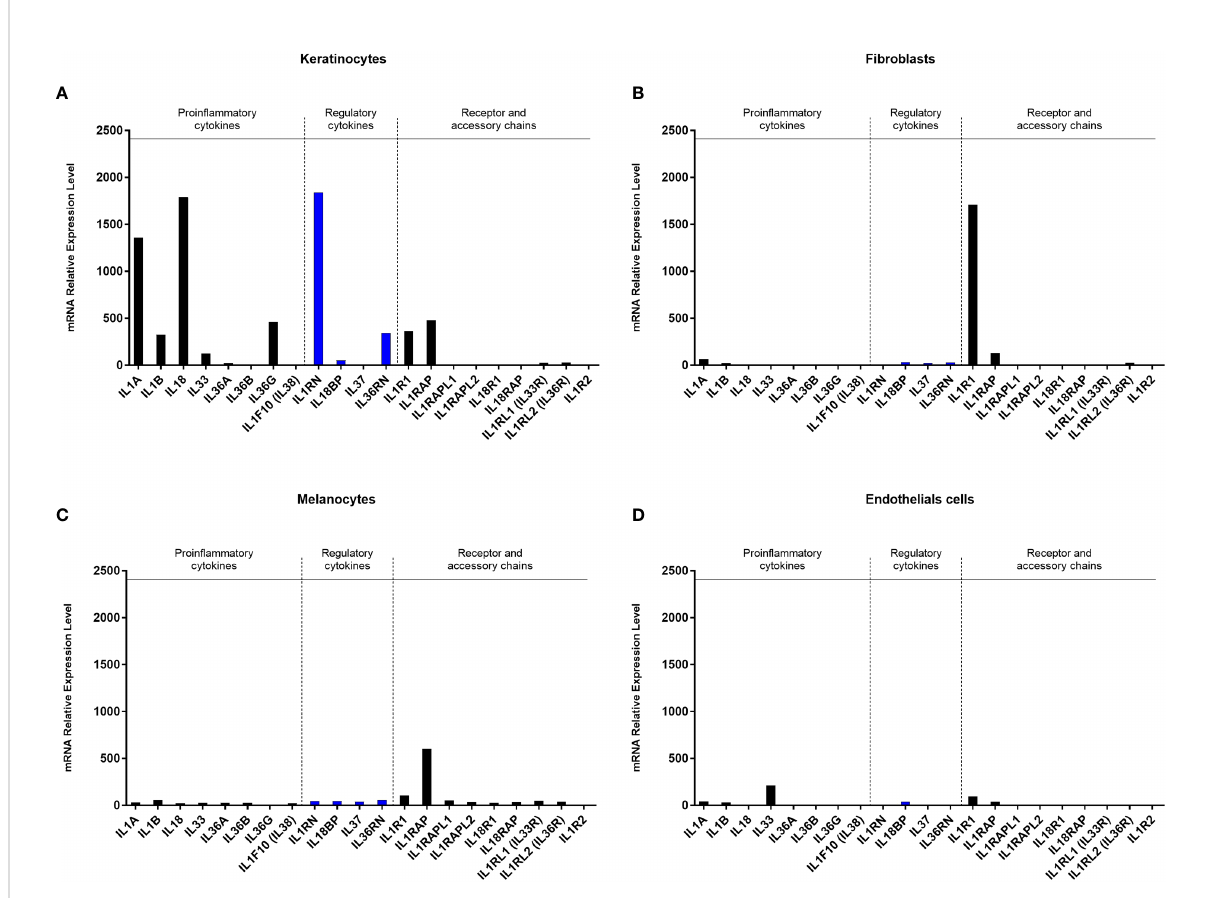
FIGURE 1 Gene expression pro fi les of proin fl ammatory cytokines, regulatory cytokines and receptors of the IL-1 family by different skin cell populations. The expression of the IL-1 family members and their receptors was analyzed at the transcriptional level by Affymetrix analysis (hU219 array) after mRNA extraction of primary cultures of epidermal keratinocytes (A) , dermal fi broblasts (B) melanocytes (C) and dermal microvascular endothelial cells (D) , all isolated from human skin and cultivated in healthy conditions. Averaged data obtained from 2 independent cultures for each cell type are presented in relative expression of the gene of